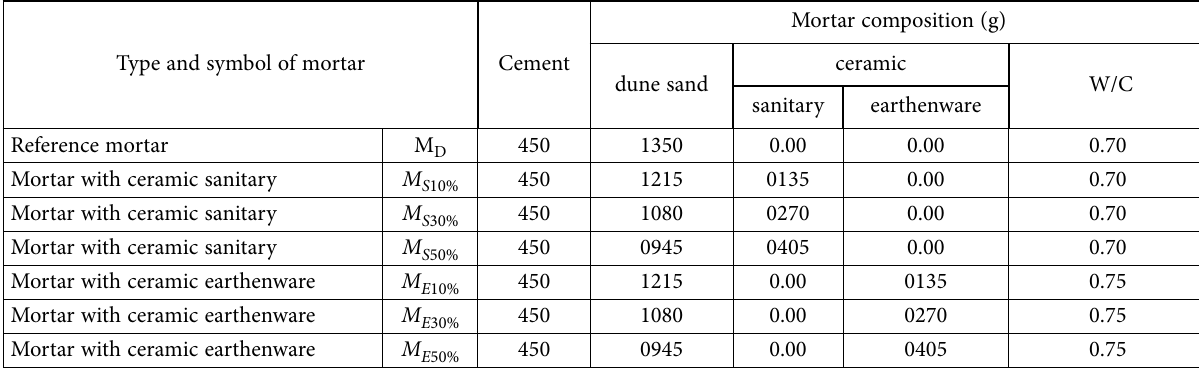
Table 1. Composition of designed